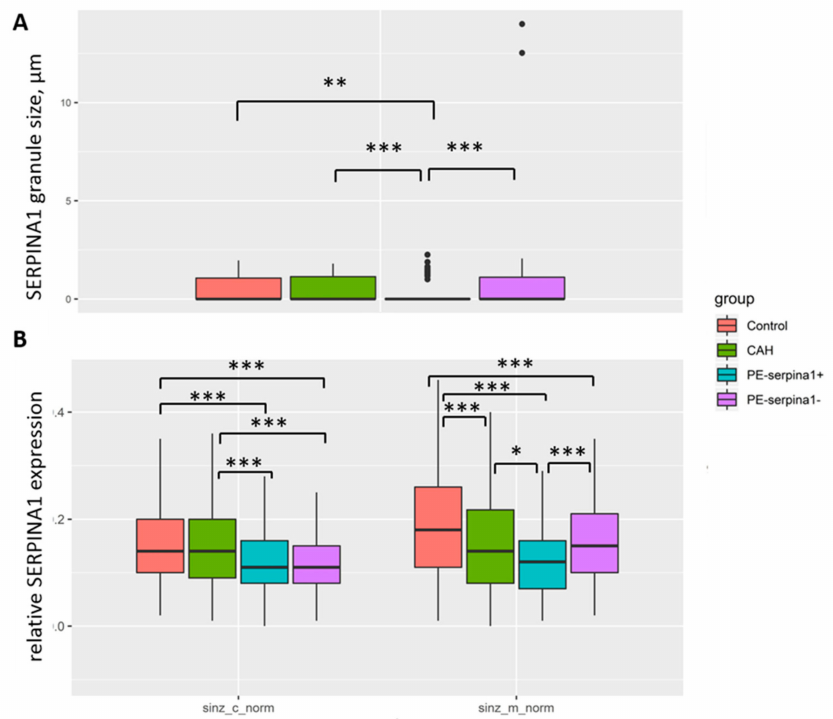
Figure 5. Comparison of SERPINA1 expression in syncytiotrophoblast according to immunohistochemistry: ( A ) SERPINA1 granule sizes ( µ m); ( B ) the relative level of expression of SERPINA1 in the membrane and cytoplasm of syncytiotrophoblast. The results are given for the four study groups. *— p < 0.5; **— p < 0.01; ***— p <